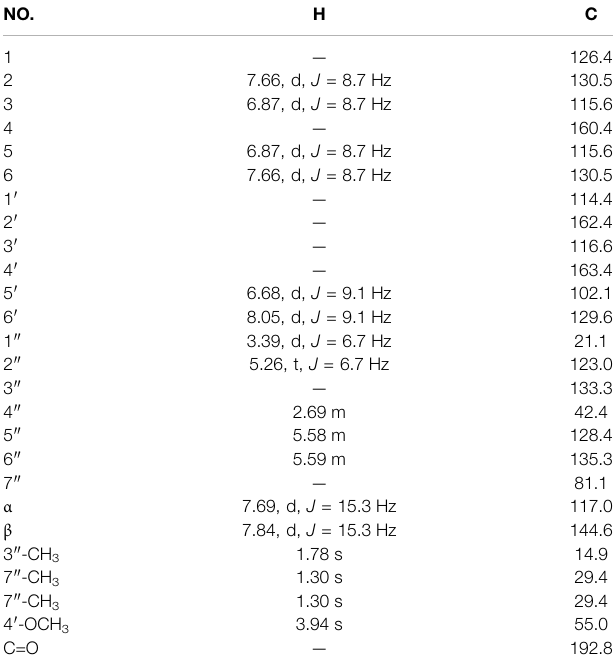
TABLE 3 | 1 H NMR and 13 C NMR data of compound 3 in MeOH (700 MHz).